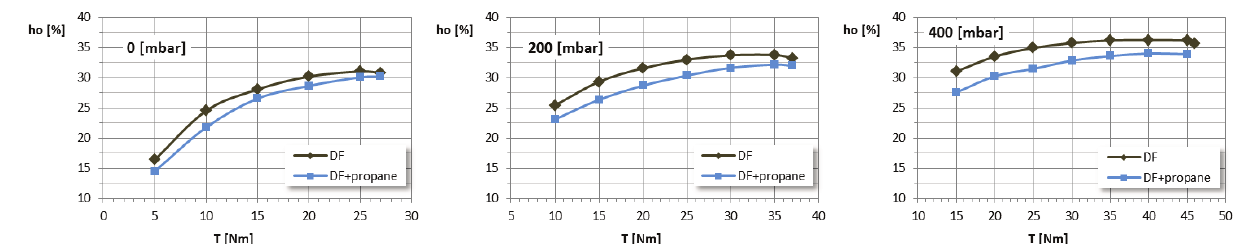
Fig. 3. Load characteristics of overall efficiency for investigated engine